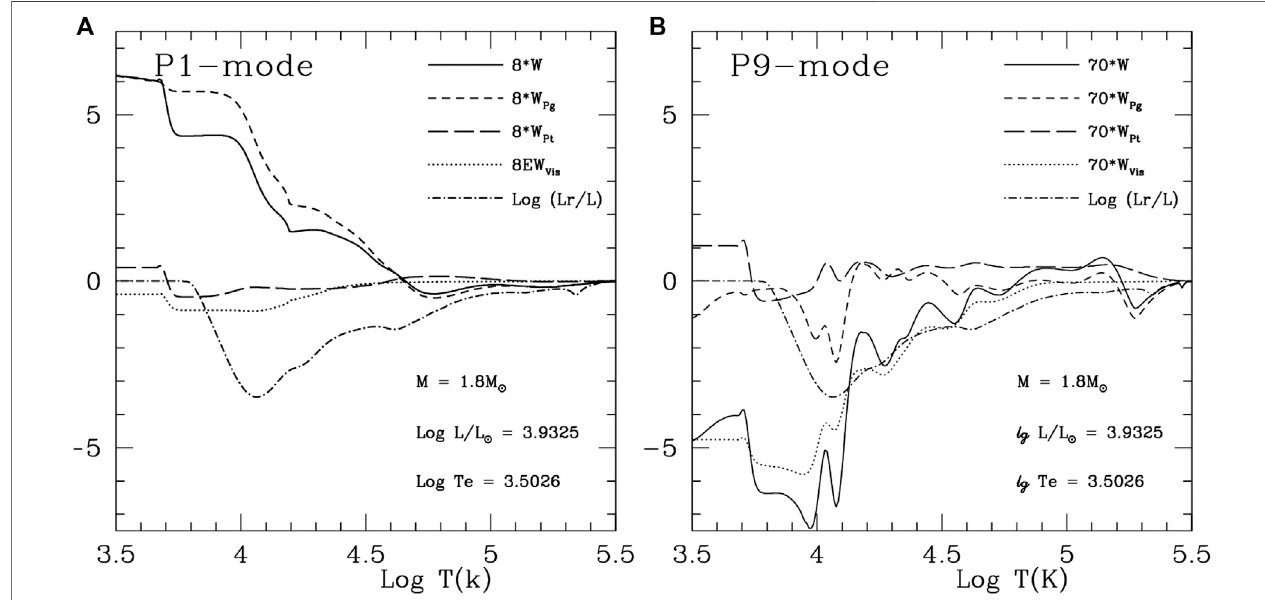
FIGURE 2 | The same as Figure 1 , but for a high-luminosity red